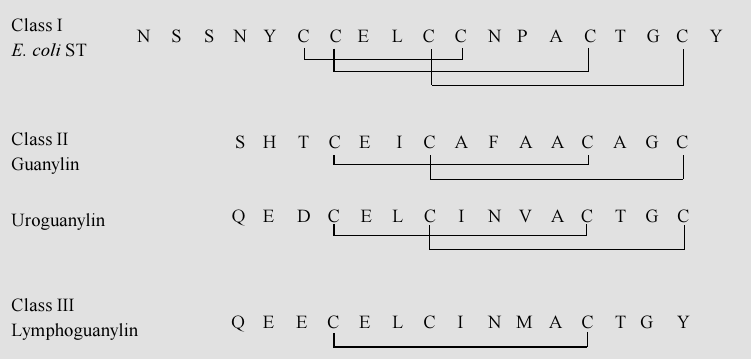
Figure 3 - Comparison of the primary structures of subclasses within the guanylin family of biologically active peptides. The peptide subclasses are provided from top to bottom in the order of their discovery as: Class I peptides containing 3 disulfides, class II peptides with 2 disulfides and class III peptides that have only 1 intramolecular disulfide bond. The single letter abbreviation is used to designate amino acid residues in each peptide. E. coli ST, E. coli stable